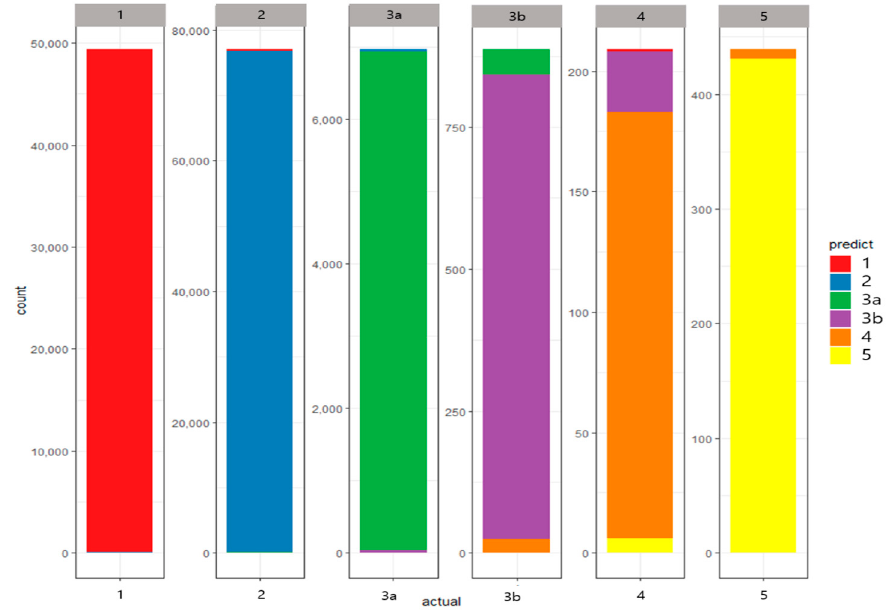
Figure 5. Confusion matrix for autoencoder (AE) based on 10-fold cross validation.